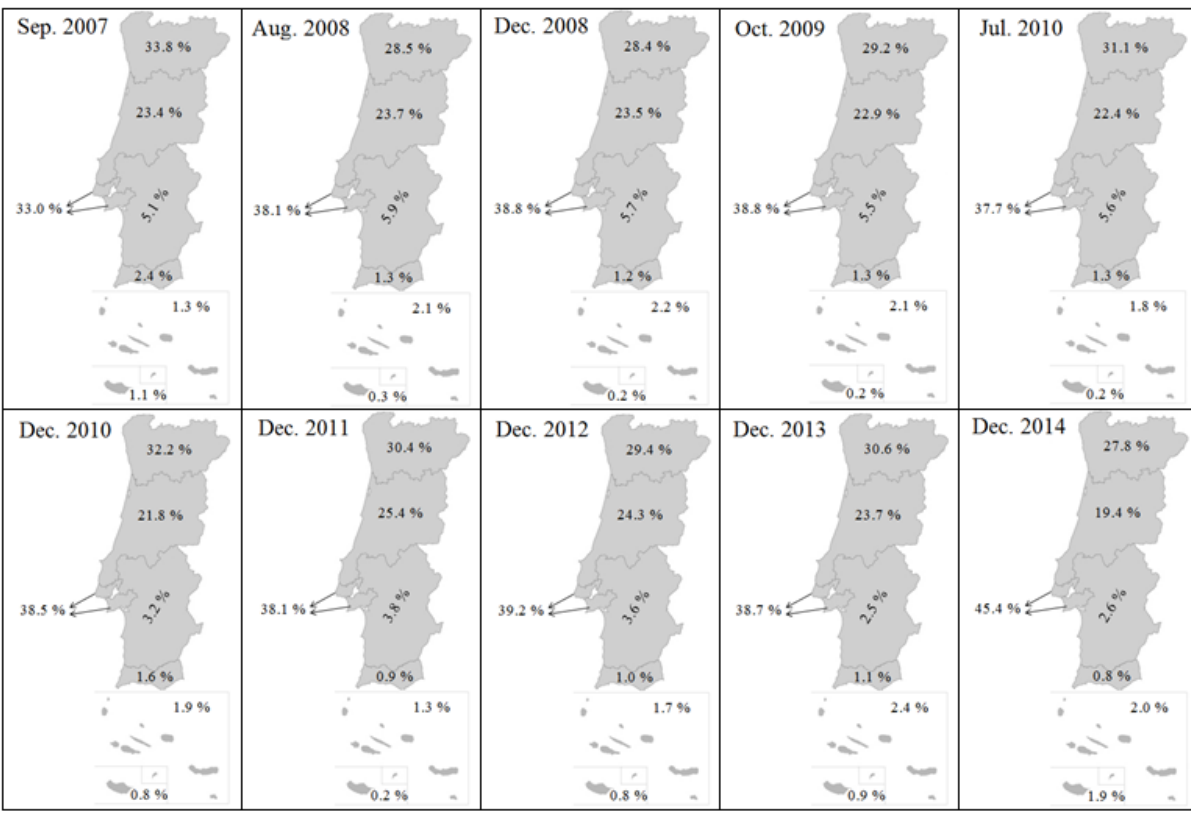
Figure 4. Evolution of OHSAS 18001 certificates- Breakdown by NUT II